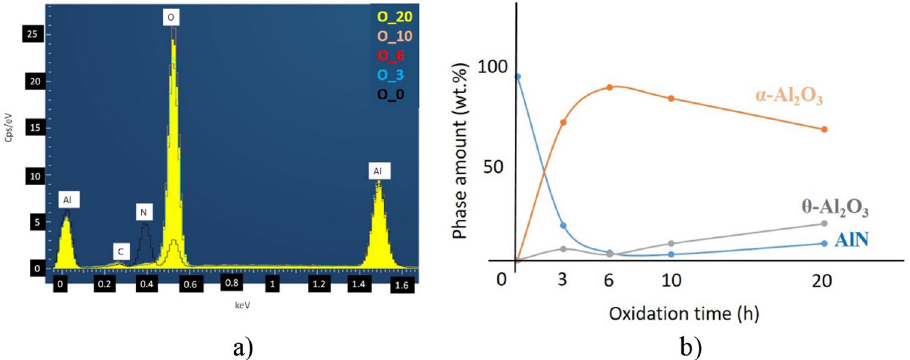
Figure 3. Elemental composition of oxidized AlN. ( a ) Elemental map of powders*, ( b ) quantitative results calculated from XRD. *C is a contamination from carbon tape.